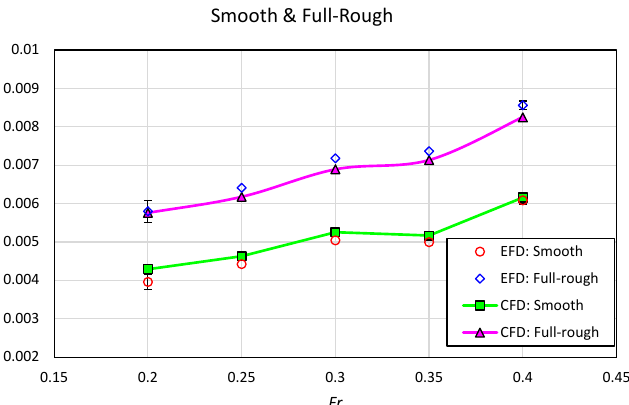
age differences between the CFD and EFD results can be found from Table A1 in Appen- dix A.